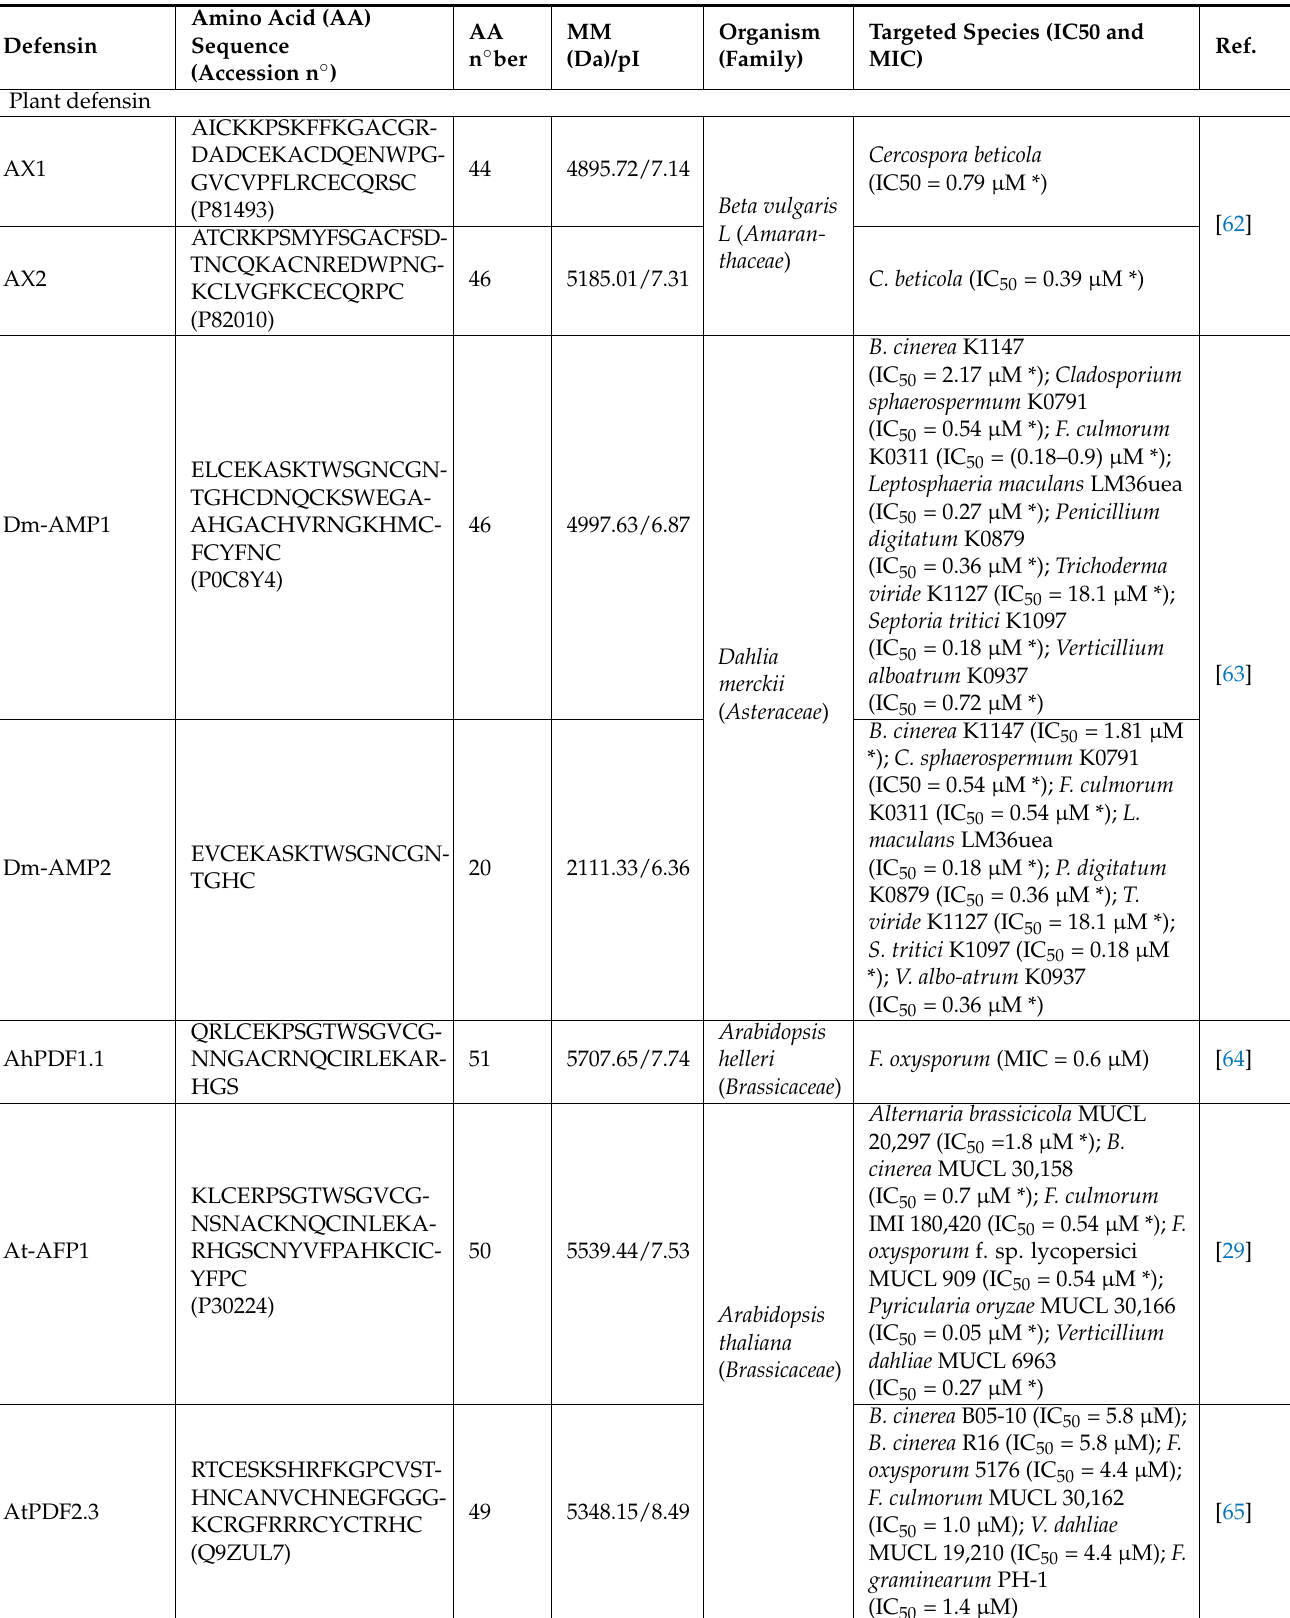
Table 1. List of defensins and DLPs with antifungal effect on phytopathogenic and mycotoxigenic